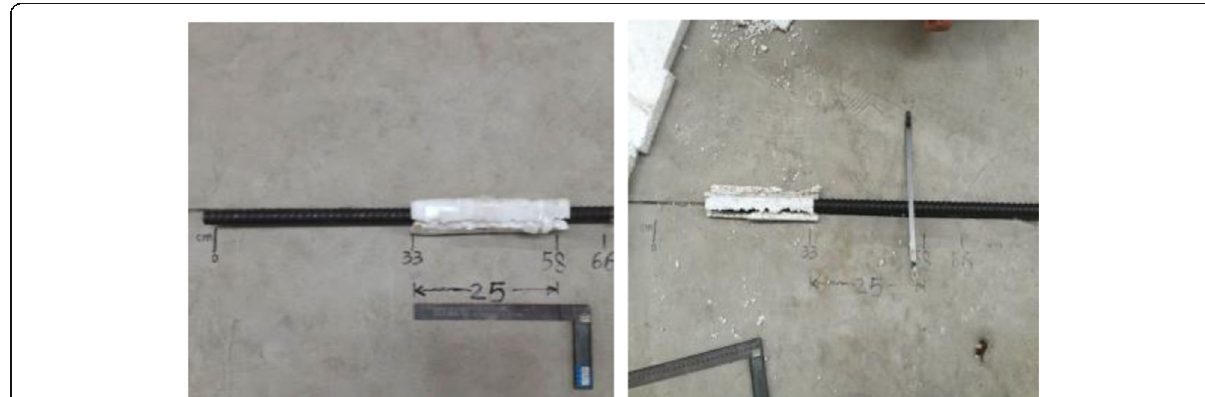
Fig. 3 The schematic diagram of the defect length and the position